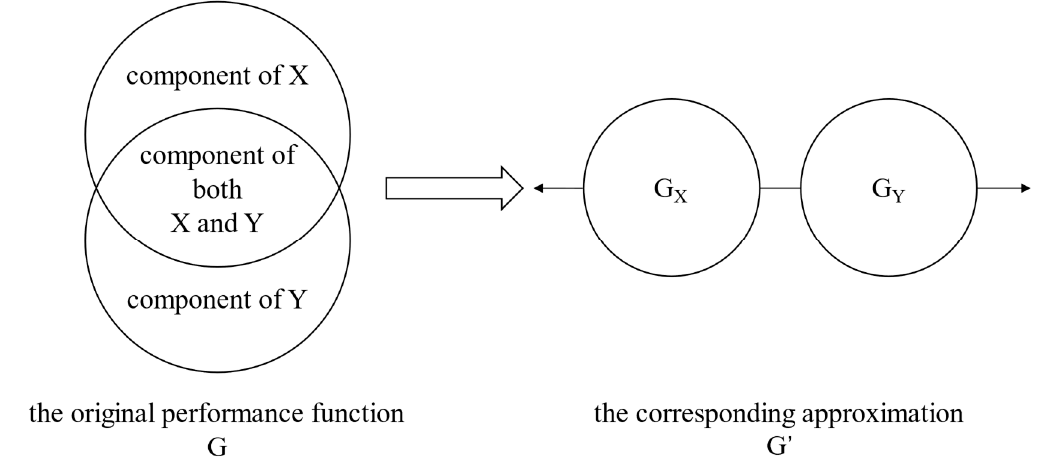
Figure 1. Conceptional illustration of the proposed method.